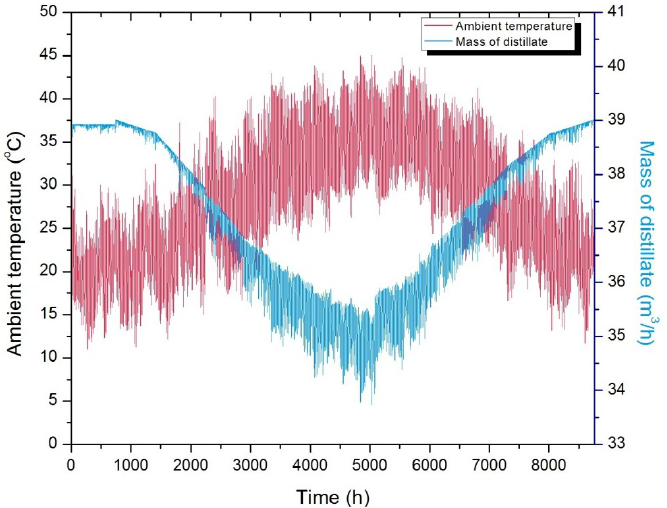
Figure 12. Effect of ambient temperature on distillate